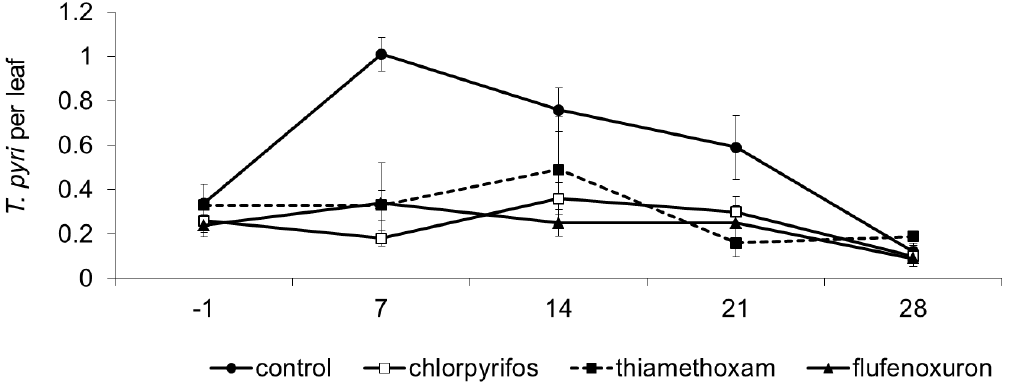
Figure 2. Population dynamics of Typhlodromus pyri (mean ± std. err.) observed in